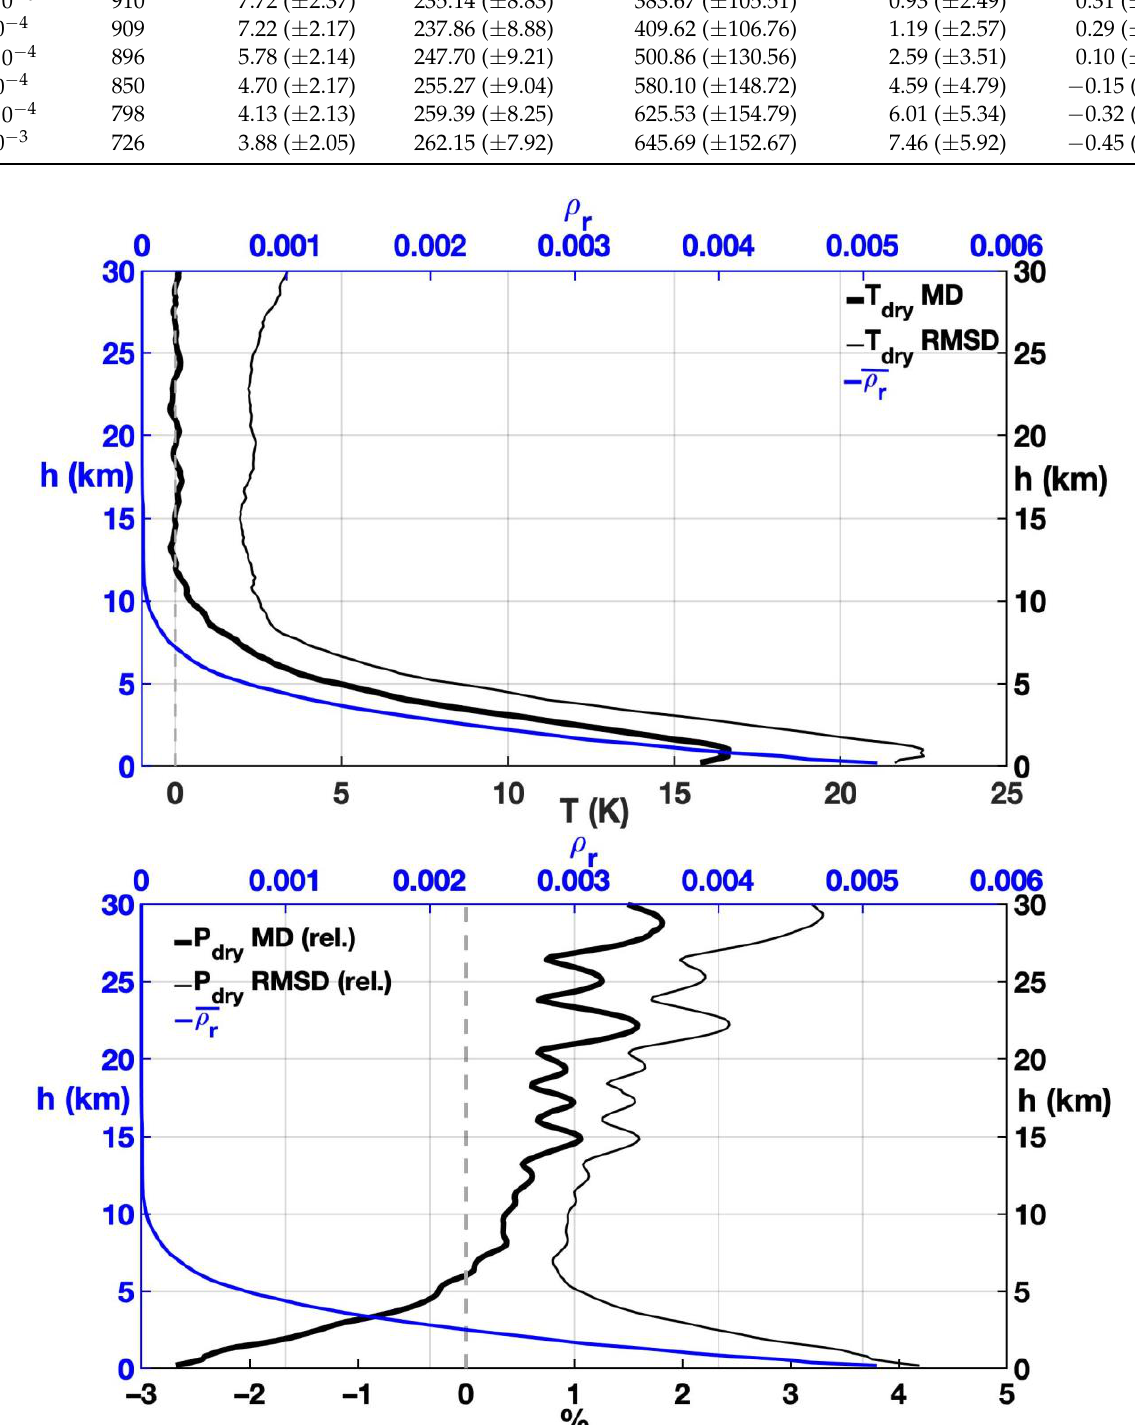
Figure 3. ( Top ) Vertical profiles for the mixing ratio mean values (blue) and for the dry temperature mean deviations (thick black line) and the root mean square deviations (thin black line) with respect to the air temperatures measured by balloon excursions ( bottom ). Analogous profiles for pressures.